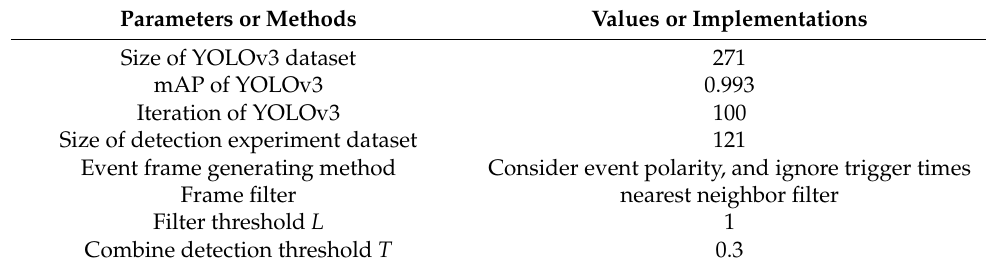
Table 2. Experimental parameters and dataset